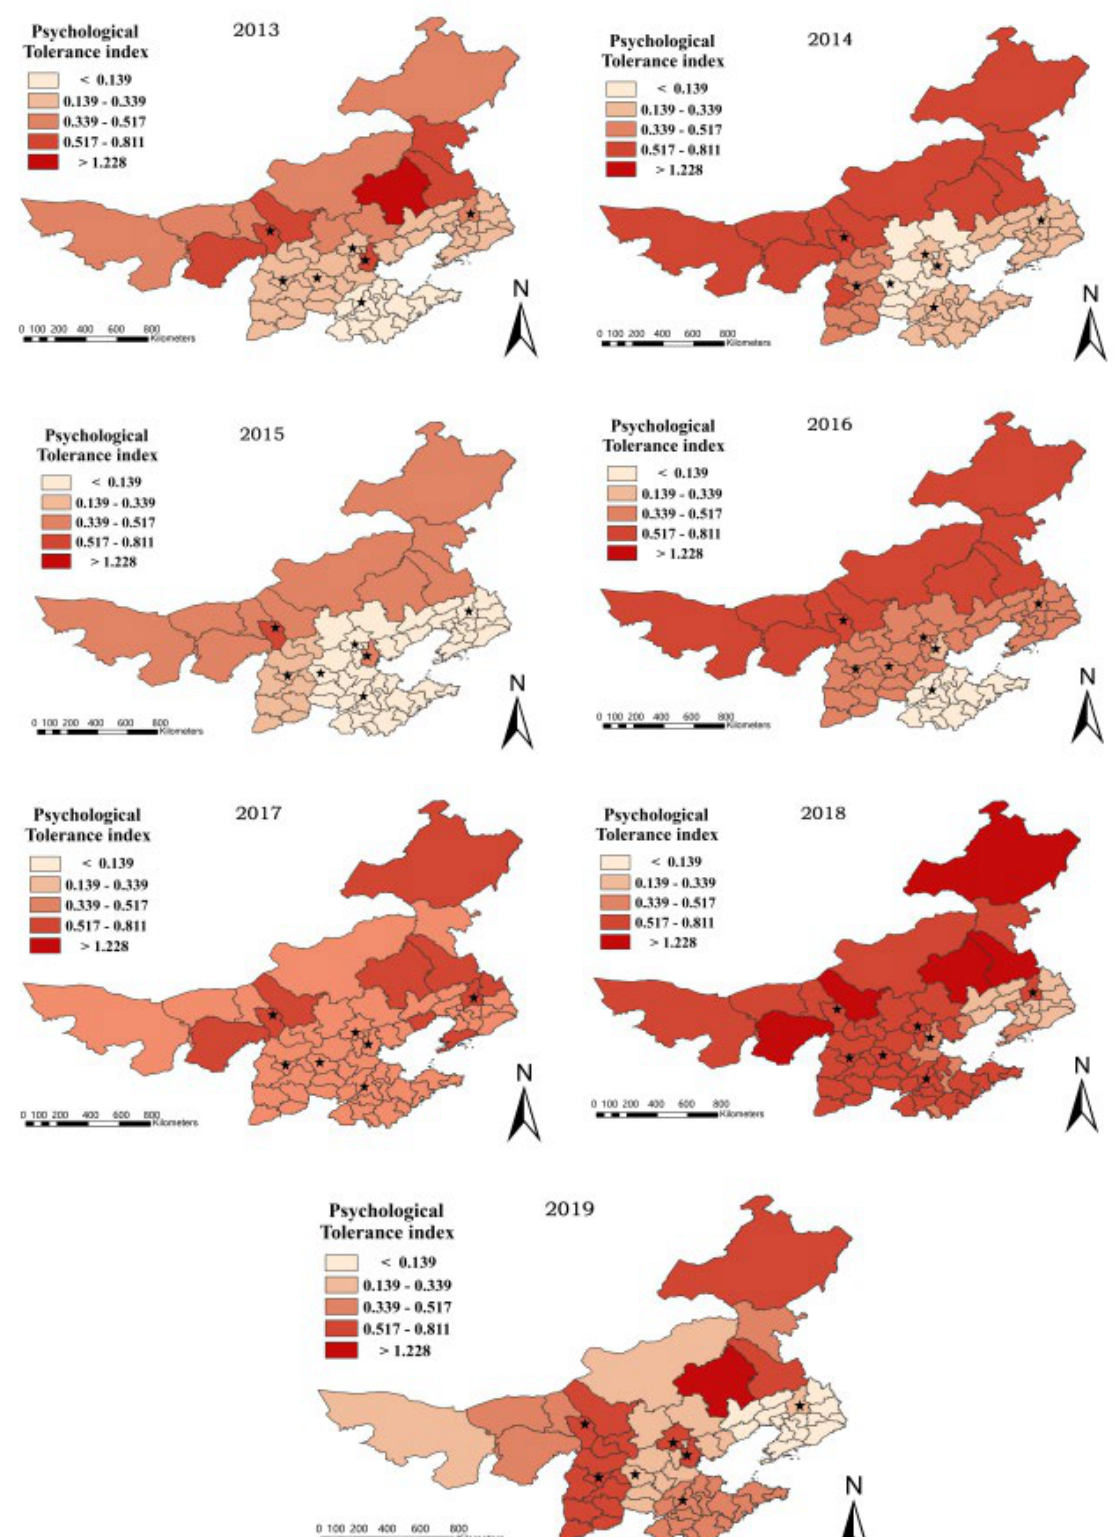
Figure 8. Psychological tolerance’s temporal and spatial distribution in prefecture-level cities. (The stars indicate the capitals of seven provinces).